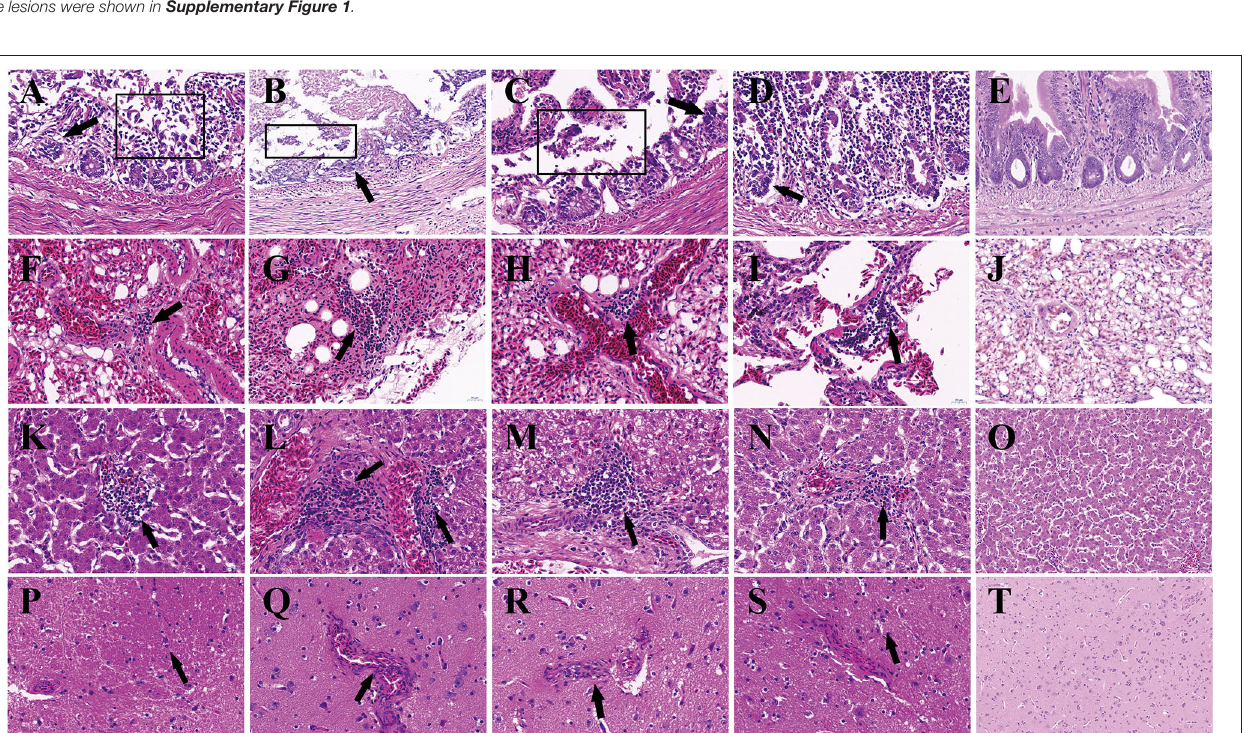
Frontiers in Veterinary Science |